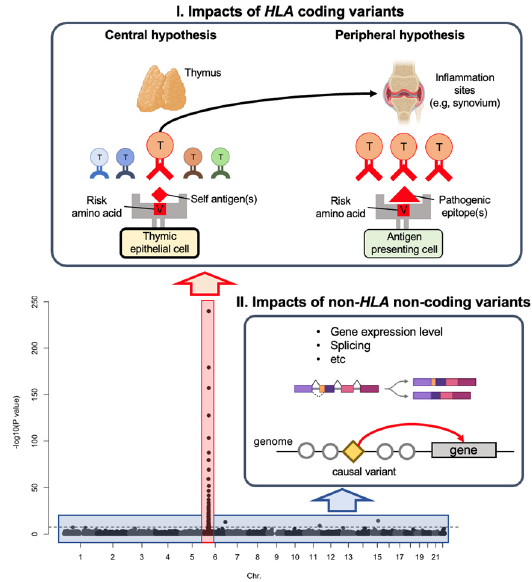
Figure 2. Two genetic risk categories of autoimmunity. In this review article, we introduced two categories of genetic risk of autoimmunity. One of our recent studies suggested that HLA coding variants influence thymic selection, modify TCR repertoire, and increase the auto-reactive immune response (the “central hypothesis”) [13]. Other researchers reported that HLA coding variants influence the binding affinity of pathogenic epitopes and enhance immune reactions against them (the “peripheral hypothesis”). On the other hand, non- HLA non-coding variants are enriched in the regulatory region and probably influence gene expression and splicing. We used p -values in our recent multi-ancestry of RA-GWAS for the bottom Manhattan plot [1]. We used images of the thymus, joint, and splice isoforms from BioRender (https://biorender.com/, accessed on 2 January